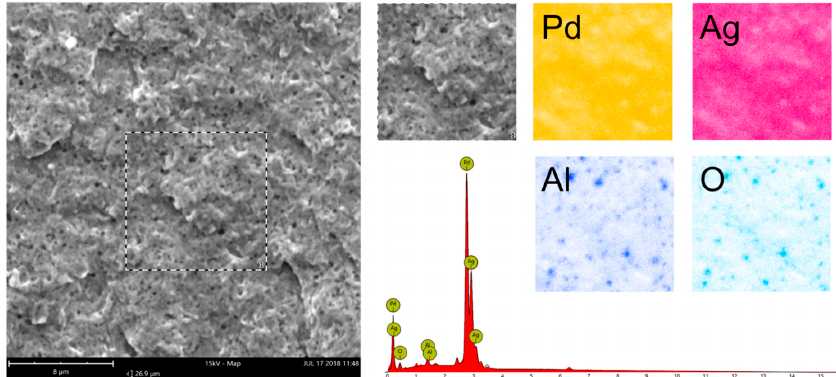
Figure 16. Energy Dispersive Spectroscop (EDS) on membrane 4b section B after 1150 h and fluidization up to 500